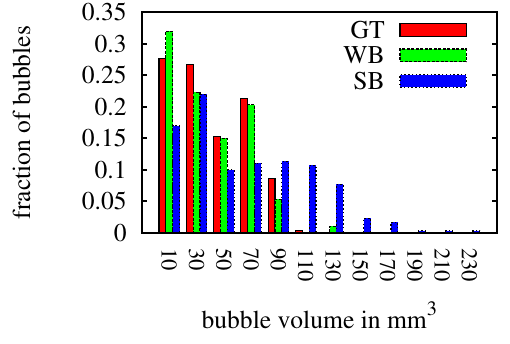
Figure 16. Histogram showing the bubble volume distribution on synthetic data computed in the wide-baseline scenario and the small-baseline scenario compared to ground